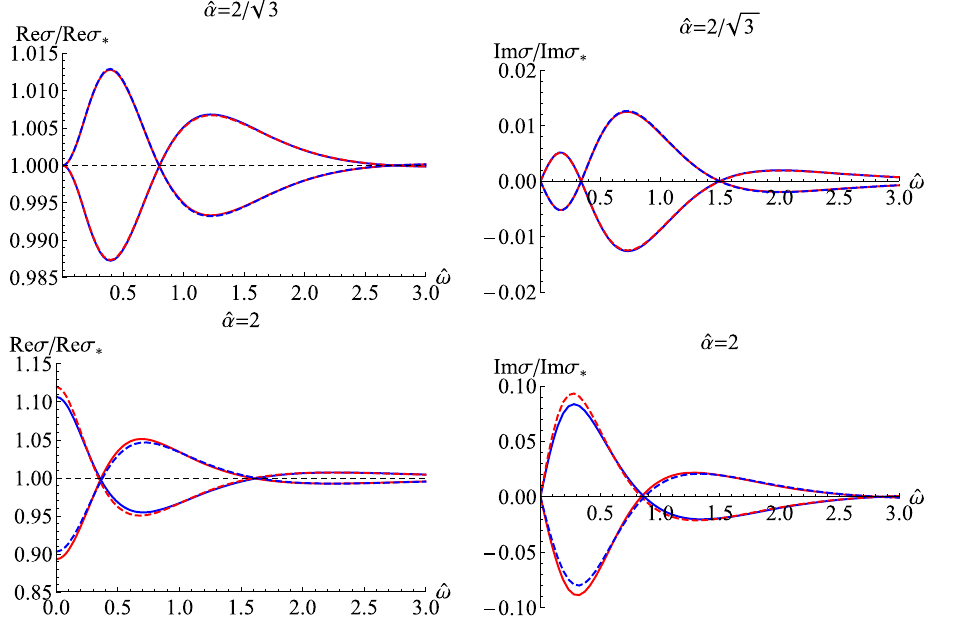
Fig. 13 The optical conductivity as a function of ˆ ω for various values of γ 1 , 1 and ˆ α . The solid and dashed curves are the conductivity of the original EM theory and its dual theory, respectively (red for γ 1 , 1 = 1 / 50 and blue for γ 1 , 1 = − 1 / 50)